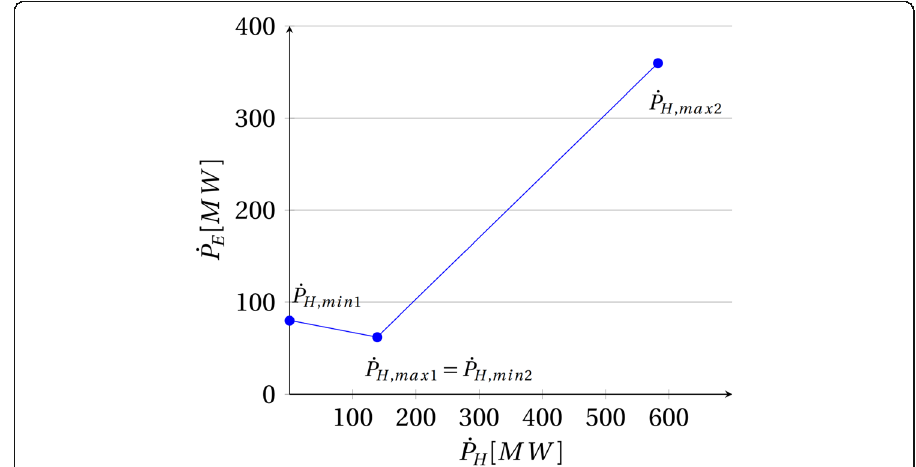
Fig. 2 Illustration of the two line-segments used to model the electricity production as function of heat production. The binary z-variable controls which line is